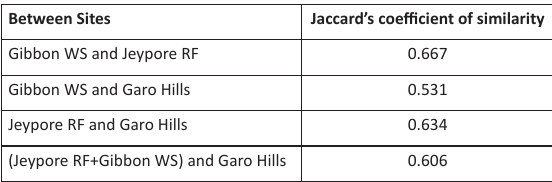
Table 2. Similarity index of papilionids in different areas having ‘semi-evergreens forest’ in northeastern